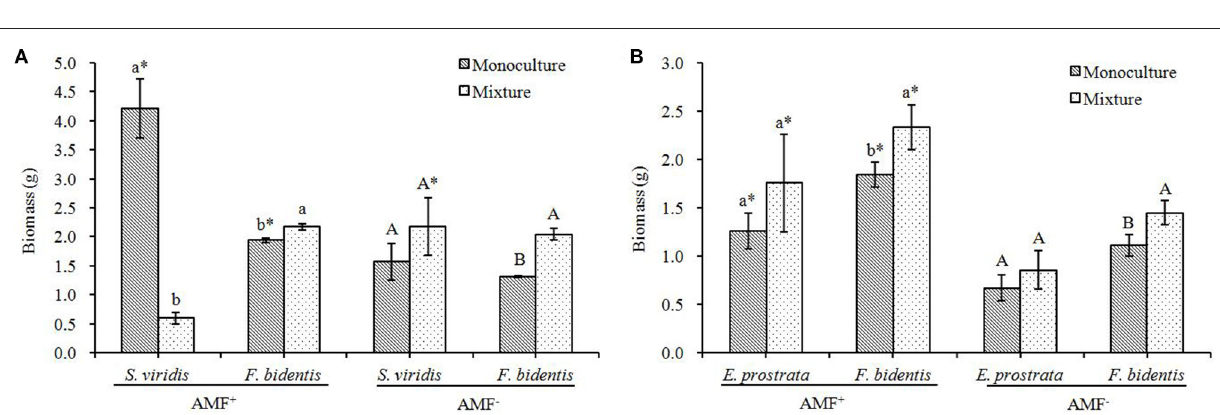
FIGURE 3 | Effects of R. intraradices on the total dry biomass of exotic plant F. bidentis and two native plants S. viridis (A) and E. prostrata (B) when grown in monoculture or in mixture. Different lower case letters indicate significant difference between monoculture and mixture treatments with inoculation of R. intraradices at P < 0.05. Different capital letters indicate significant difference between monoculture and mixture treatments without inoculation of R. intraradices at P < 0.05. * indicate significant difference between inoculation and non-inoculation treatments at P < 0.05. Error bars represent ± SE of mean ( n =